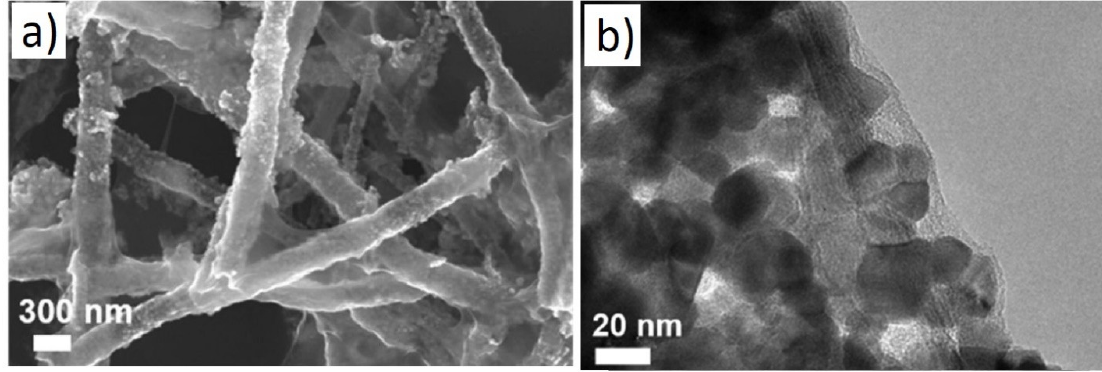
Figure 10. NO 2 sensing mechanism in ( a ) SnO 2 NFs and ( b ) rGO-loaded SnO 2 NFs [63]. Hollow NFs are also interesting morphologies for gas sensing studies because of their higher surface areas that can interact with gas species [64].For example, a BET sur- face area of hollow SnO 2 NFs composited with GO was reported to be 33.4m 2 /g. In this regard, Li et al. [65] investigated rGO-loaded SnO 2 NFs for gas sensing studies. Figure 11 shows typical SEM and TEM images of rGO-loaded SnO 2 NFs.